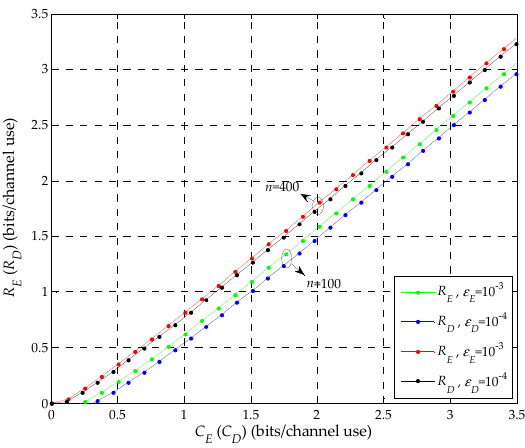
Figure 2. R E vs C E and R D vs C D .